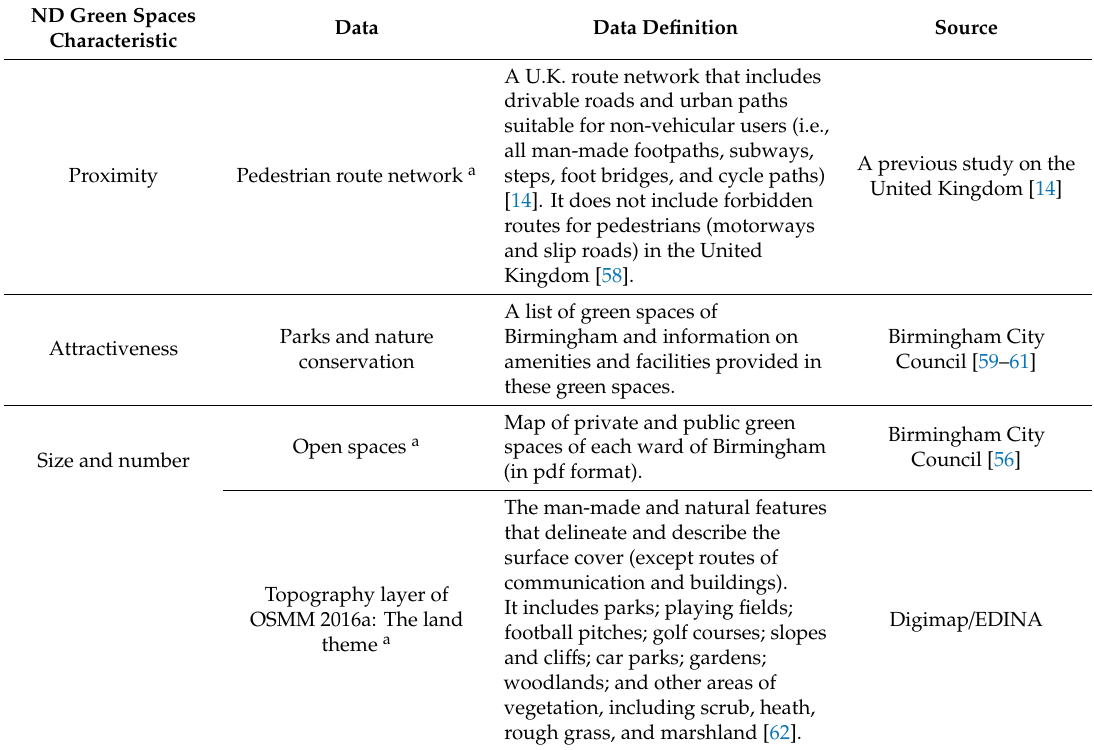
Figure 2. Participants’ homes in low- and high-deprivation areas (adapted from the work of [13]) and digitised public green spaces included in study (data from Birmingham City Council [56] and Ordnance Survey (OS) MasterMap data © Crown Copyright/database right 2016. An Ordnance Survey/EDINA Digimap (the national data centre for U.K. academics) supplied service). Table 2. Data used for objective measures of neighbourhood green spaces characteristics.